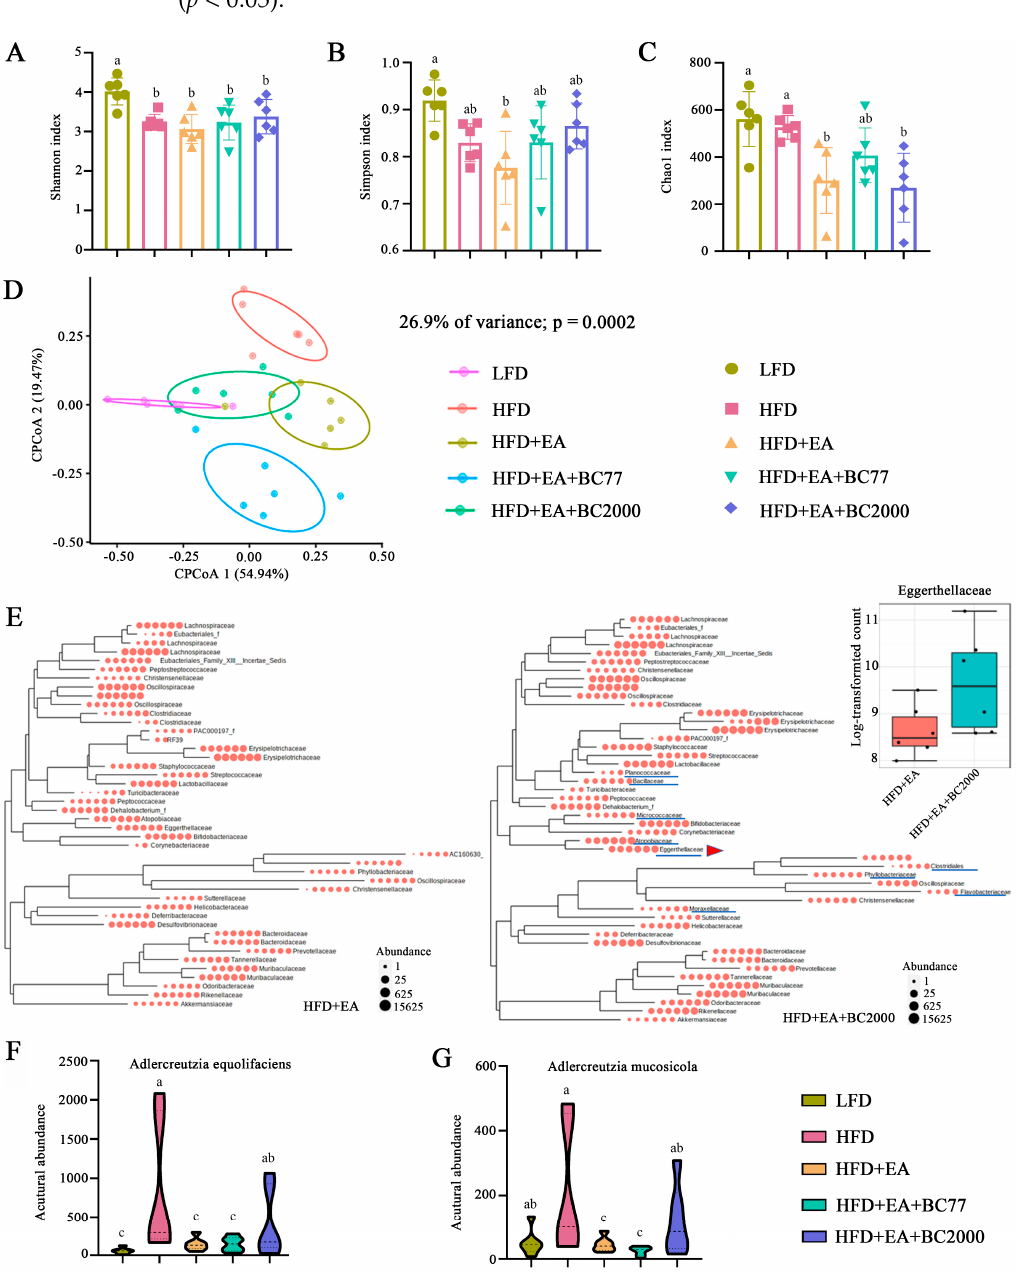
Figure 4. Impact of BC2000 on cecum microbiota in obese mice: ( A ) Shannon index; ( B ) Simpson index; ( C ) Chao1 index; ( D ) CPCoA; ( E ) phylogenetic trees of gut microbiota families of HFD+EA and HFD+EA+BC2000 groups and relative content of Eggerthellaceae (inset). ( F ) The abundance of Adlercreutzia equolifaciens of Eggerthellaceae . ( G ) The abundance of Adlercreutzia mucosicola of Egger- thellaceae . Different letters indicate significant differences ( p < 0.05). n = 6/group. Values show mean ± SD. When variances in the study results were homogeneous, Tukey’s test based on one-way anal- ysis of variance (ANOVA) was used for multiple comparisons. When the variances were not homo- geneous, the Kruskal–Wallis test was used. LFD: low-fat-diet group; HFD: high-fat-diet group; HFD + EA: high-fat-diet supplemented with ellagic acid; HFD + EA + BC77: high-fat-diet supplemented with ellagic acid and W. coagulans BC77; HFD + EA + BC2000: high-fat-diet supplemented with el- lagic acid and W. coagulans BC2000. Table 2. Mouse cecum bacteria significantly affected by BC2000. ID